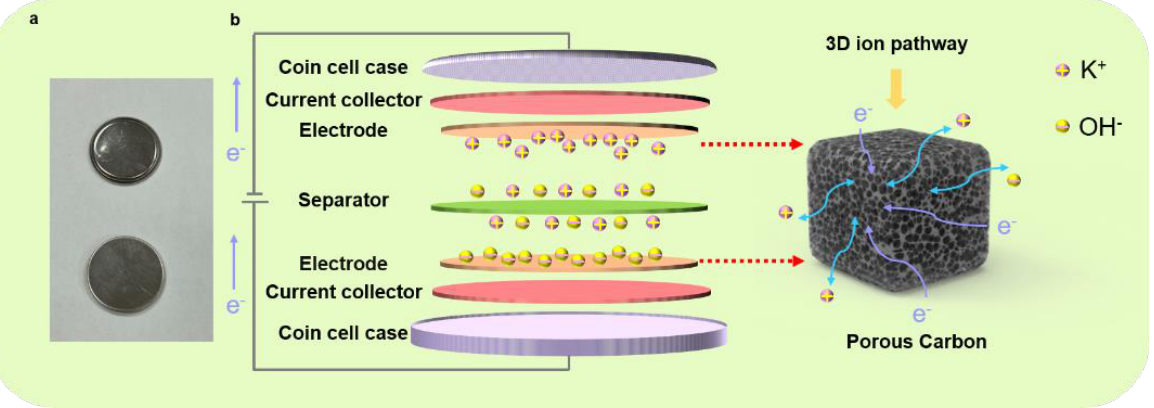
Figure 5. Digital image of the coin cell ( a ) and the schematic of the charging/discharging process of the symmetric supercapacitor ( b ).